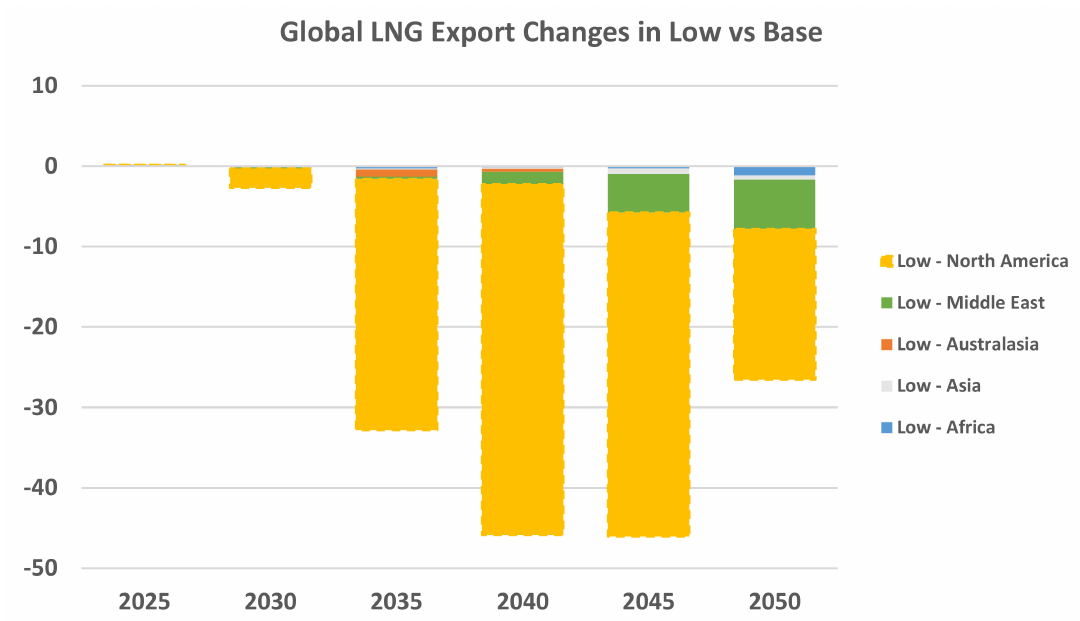
Figure 29. Global LNG export change by origin in low-carbon case vs. base